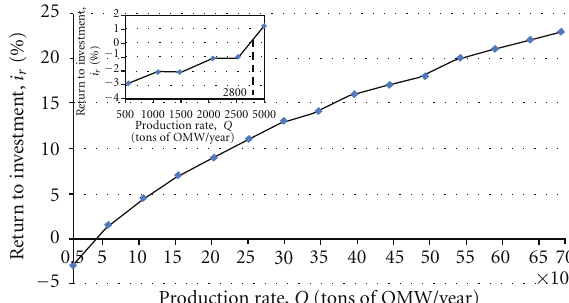
Figure 4: Return of the investment as a function of the capacity. Breakeven point (2,800t/yr) of the investment when i r equals to